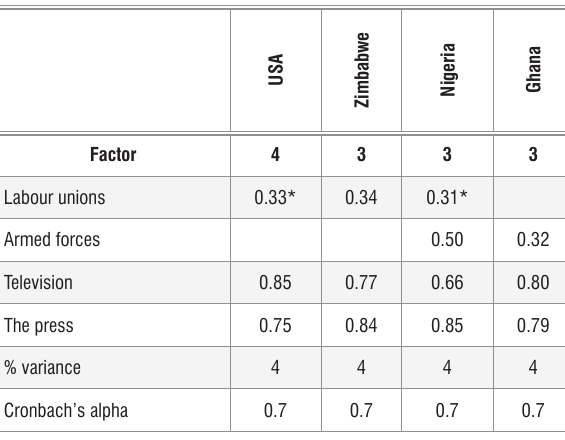
three countries: the USA, Ghana and Zimbabwe. The armed forces in the USA and Zimbabwe also belong to this group in contrast with Nigeria and Ghana where they belong to the watchdog group. There are no variables for Nigeria in this category; the police and courts are on the political